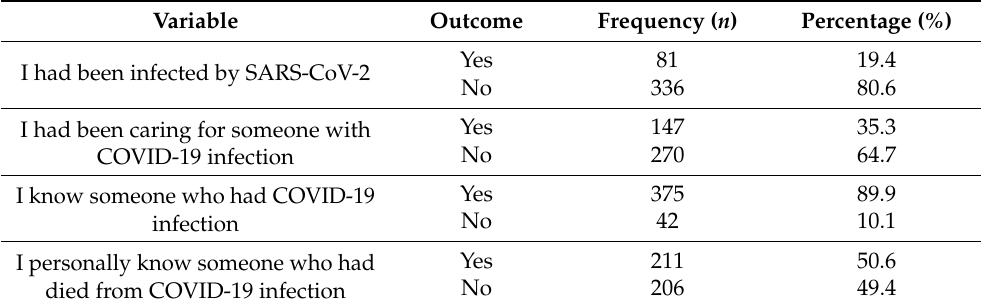
Table 2. COVID-19-related anamnesis of Palestinian dental students, February—March 2021 ( n = 417).